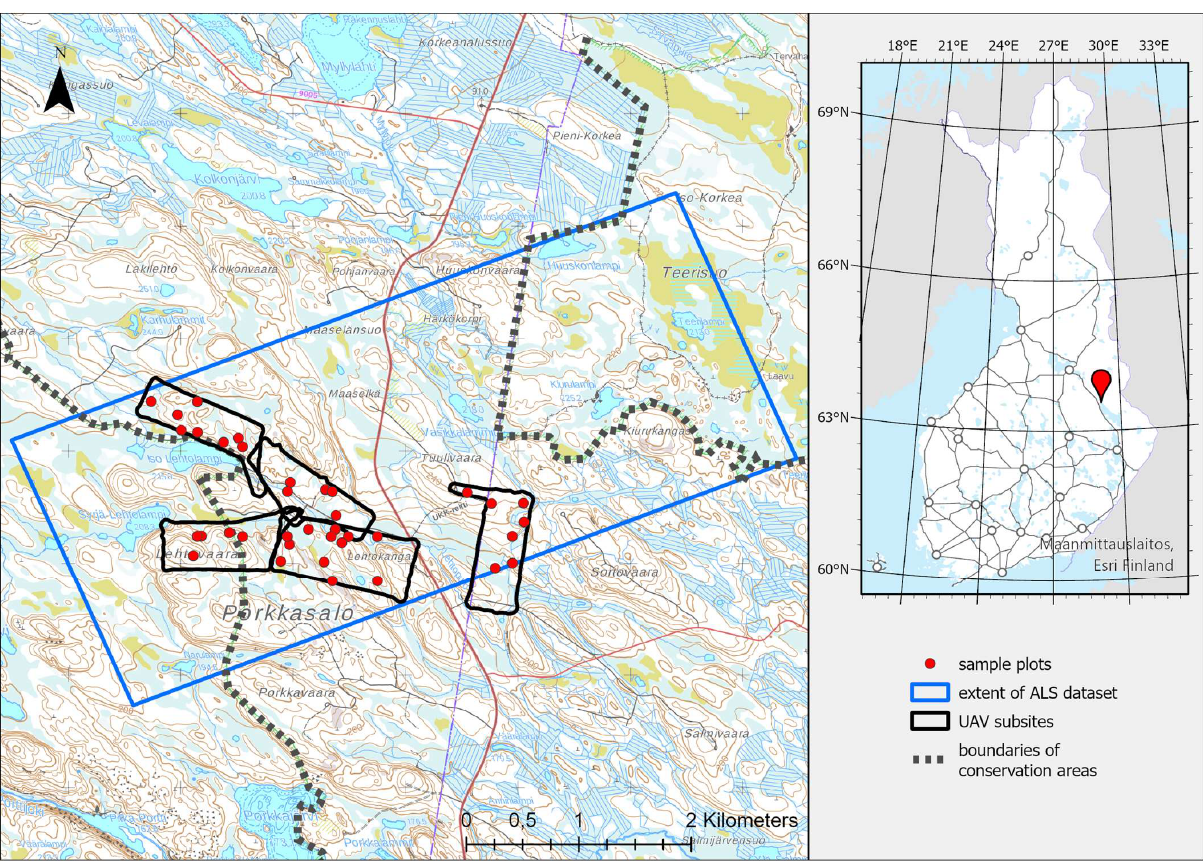
Figure 1. Map of the study site. The blue rectangle shows the boundaries of the airborne laser scanning (ALS) data, whereas the black polygons show the boundaries of the laser scanning data collected using an unmanned aerial vehicle (ULS). The red circles are sample plot locations. The western black and green dotted line depicts the east boundary of Hiidenportti National Park, whereas the eastern black and green dotted line is the west boundary of Teeri-Lososuo mire conservation area. The study area between these two natural parks is state-owned managed forest. Background maps: National Land Survey of Finland.